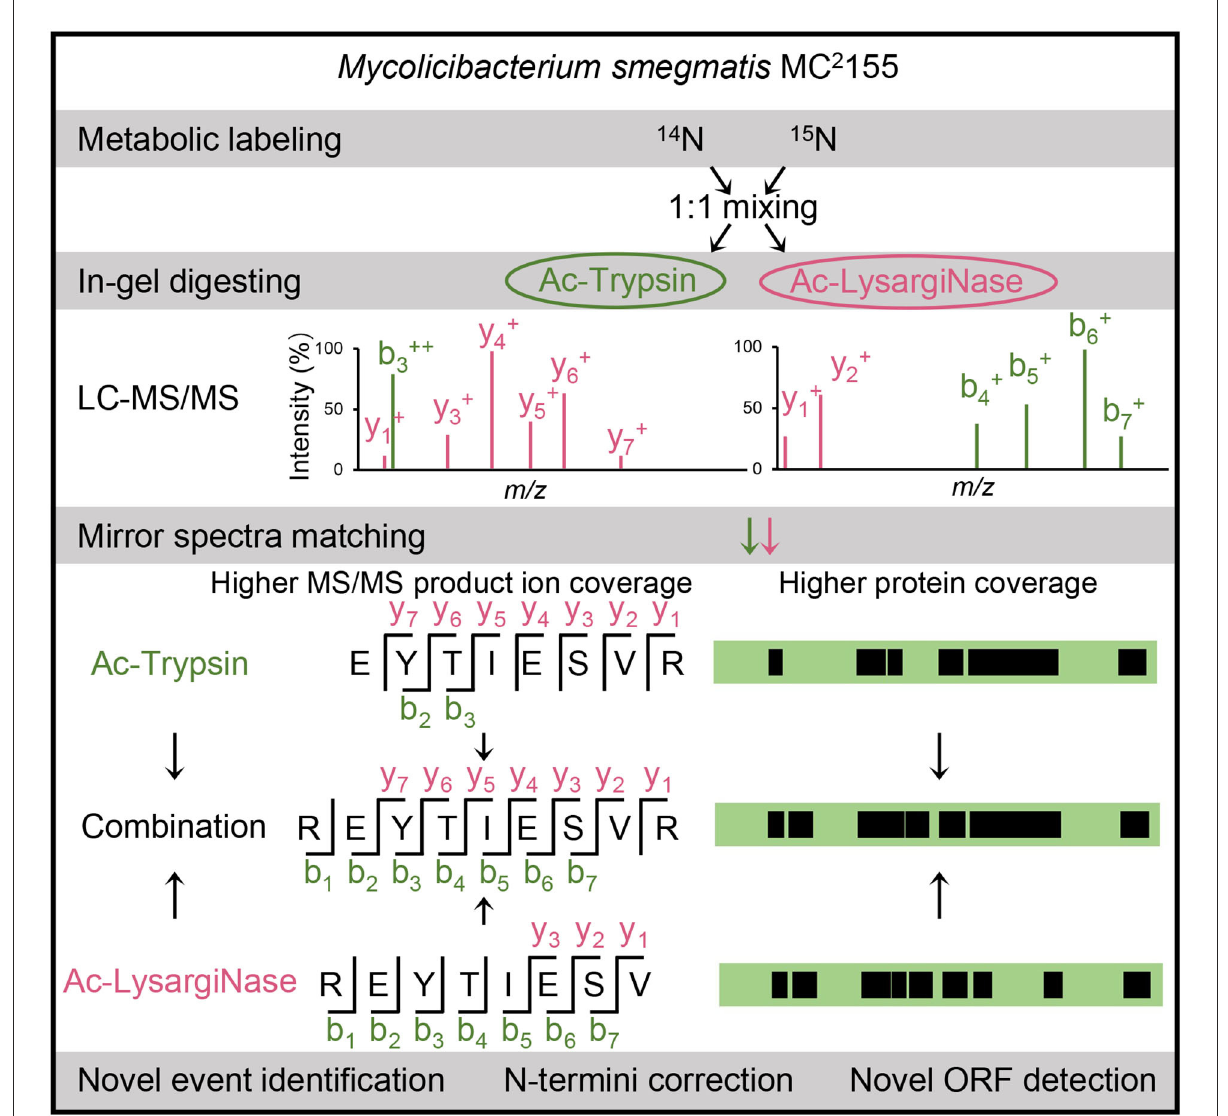
FIGURE1 Workflow of this study. Our in-house mirror proteases, Ac-Trypsin and Ac-LysargiNase, were used to assess the authenticity of novel peptides in a large-scale proteogenomic study based on 14 N- and 15 N-labeling cells of M. smegmatis MC 2 155. The verified novel peptides were further used for novel event analysis, including N-termini corrections and novel ORF identifications.